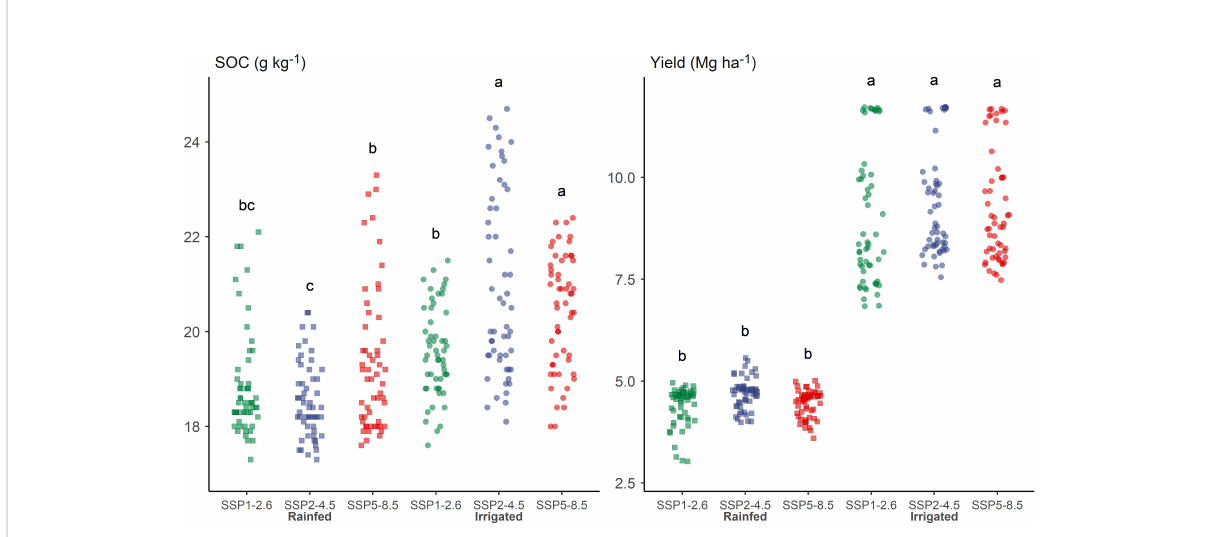
FIGURE 10 Soil organic carbon (SOC) content and alfalfa forage yield under different climate futures and irrigation assumptions in northern China from 2025 to 2035. Different letters indicate signi fi cant difference (p<